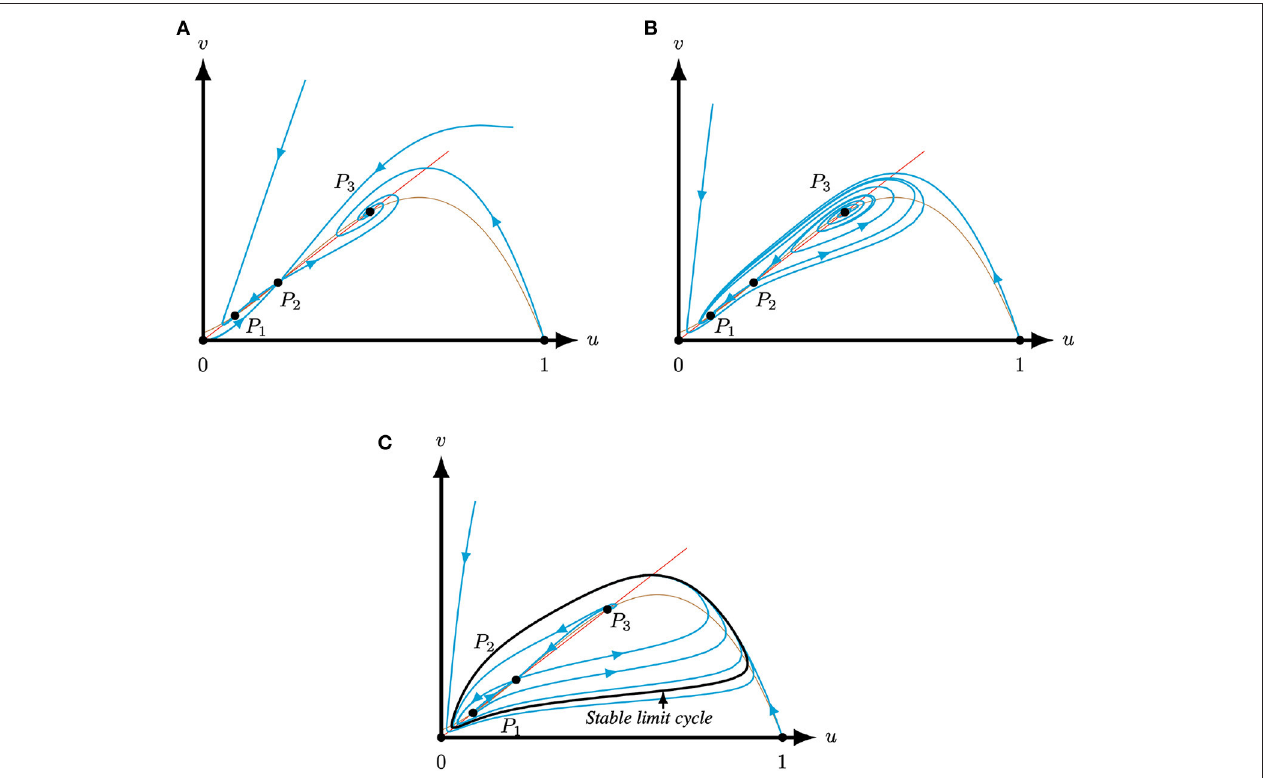
0.3 the equilibria P 1,3 are attractors. (B) For =